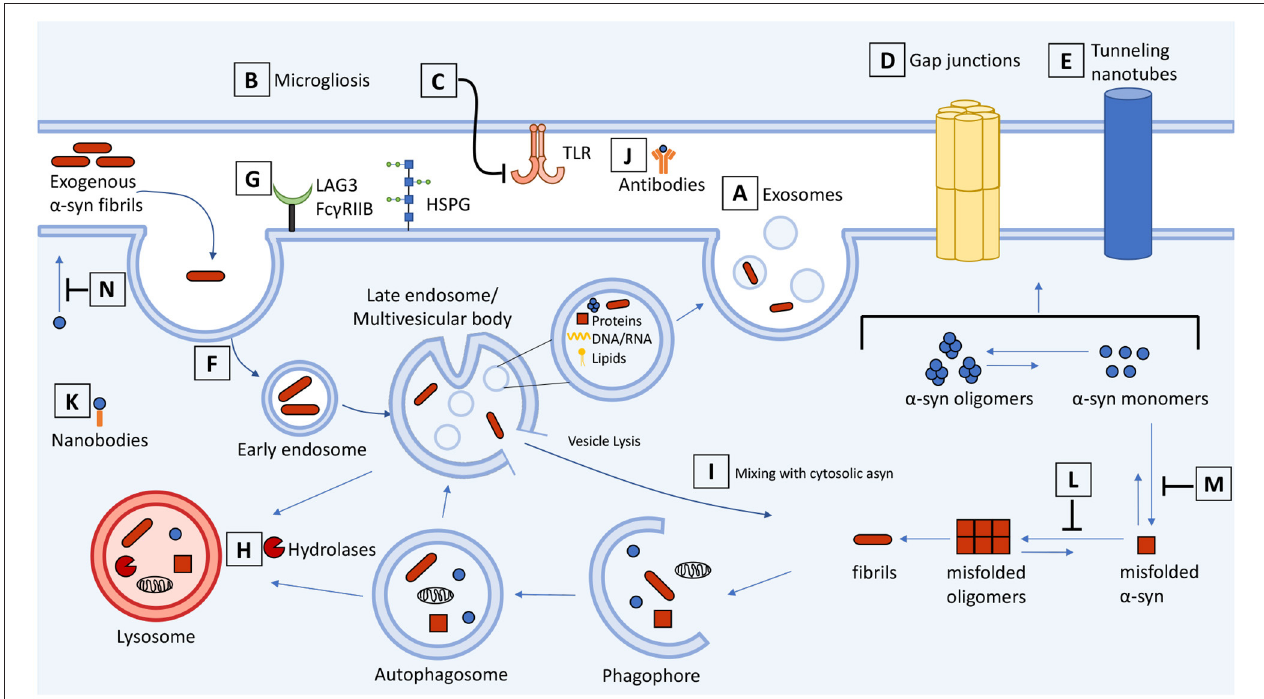
FIGURE 1 | Schematic representation of cell-to-cell transmission, internalization, and trafficking of α -synuclein and therapeutic targets along the pathways. Molecular mechanisms summarized in the context of neuron-neuron and neuron-glial transmission. (A) Secretion and exosome-mediated release of asyn from neurons and (B) activated microglia contributes to the spread of asyn. (C) Inhibitors of microgliosis and toll-like receptors reduce pathological transmission of asyn. Transmission of asyn is also mediated through direct cell-to-cell contact through (D) gap junctions and (E) tunneling nanotubes. Internalization of asyn occurs through (F) endocytosis, (G) macropinocytosis, and receptor-mediated endocytosis which can be targeted to attenuate the transmission of asyn. (H) Once internalized, asyn localizes to the endosomal compartments where it is degraded by the autophagosome-lysosome pathway. Drugs that upregulate autophagy or restore lysosome function can promote the clearance of asyn and prevent its accumulation. (I) Internalized asyn fibrils can rupture endocytic vesicles, enter the cytosolic compartment, and induce templated misfolding of native asyn. (J) Antibodies can bind and sequester extracellular asyn. (K) Antibody fragments can be expressed inside the cell and bind to and enhance turnover of intracellular asyn. (L,M) Compounds can inhibit asyn from misfolding and aggregating as well as (N) inhibit lipid-induced asyn aggregation by displacing it from the membrane. The therapeutic targets and drugs are listed in Table 1